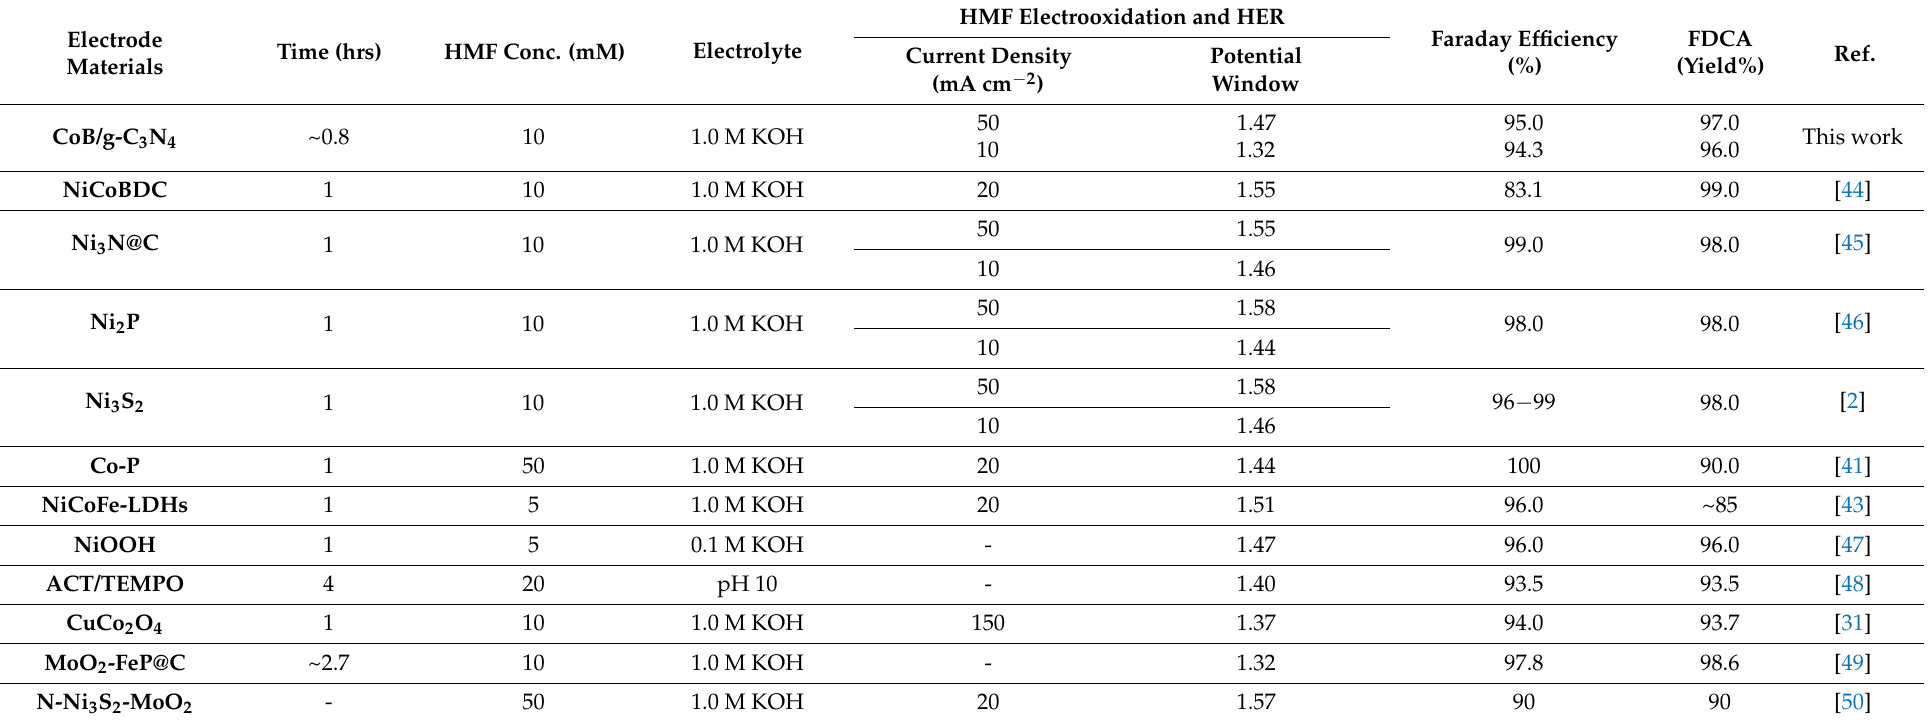
Table 2. Comparison of the total electrolysis performance of dual-function